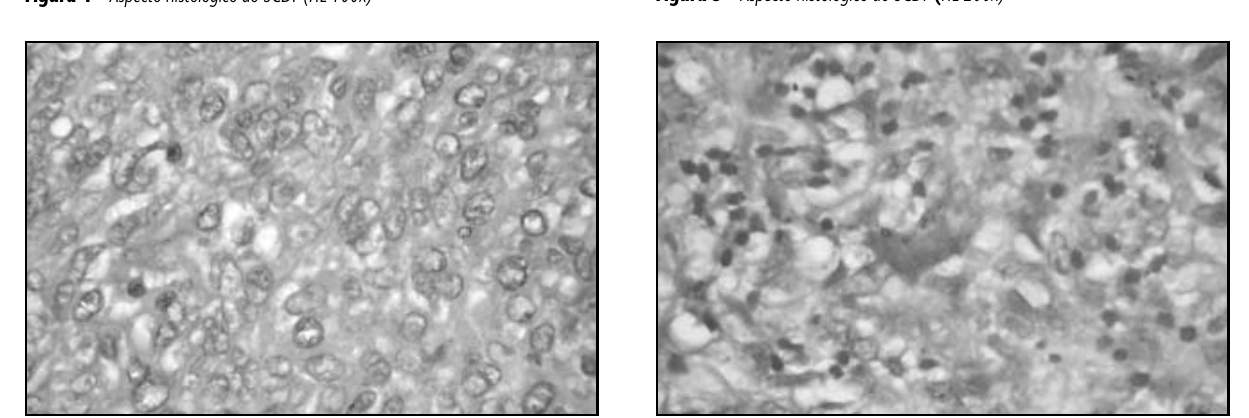
Figura 6 – Detalhe da célula neoplásica do SCDF ( HE 400x) Figura 7 – Detalhe da célula de Warthin-Finkeldey ( HE